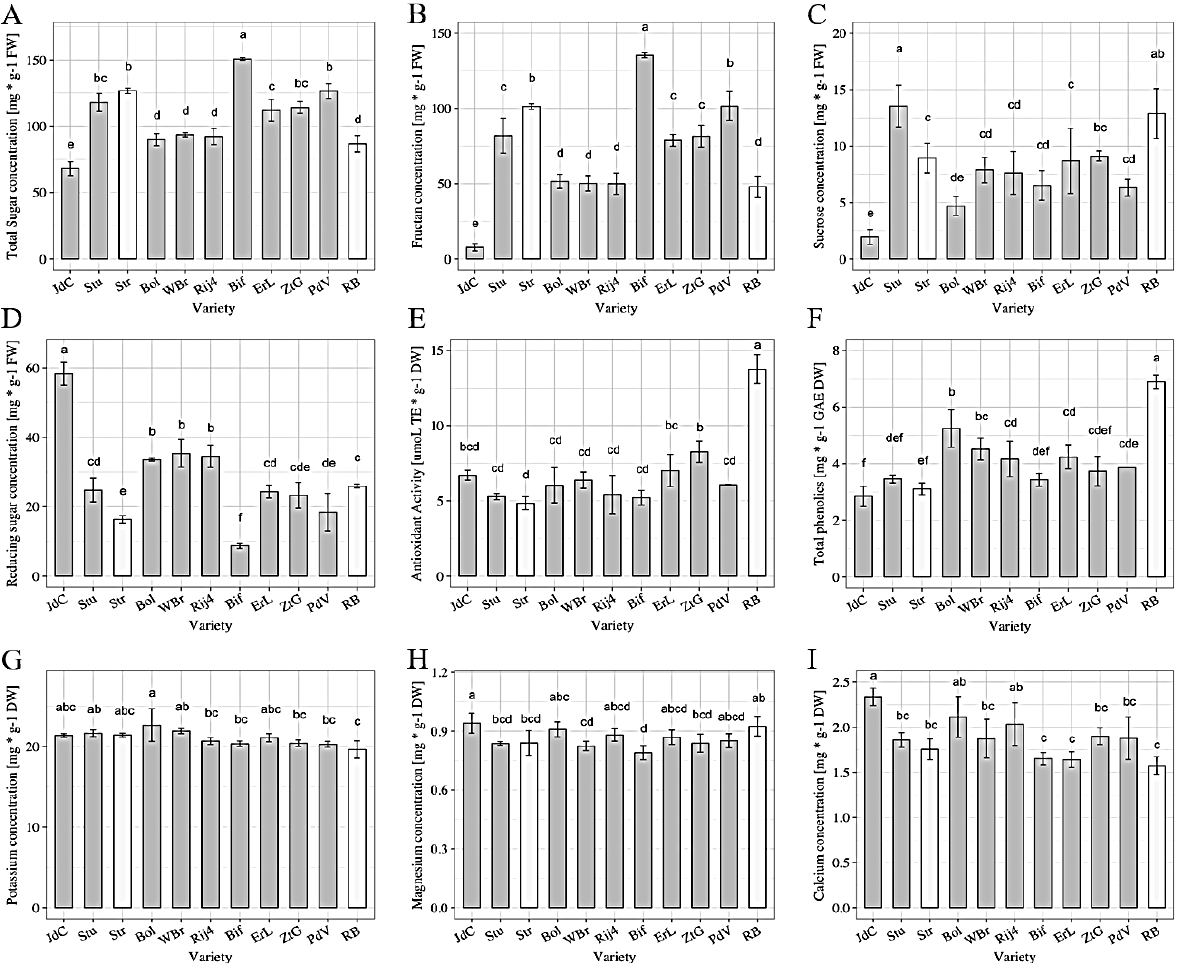
Fig. 3: Quality traits. A: Total sugar concentration, B: fructans, C: sucrose, D: reducing sugar as well as E: antioxidant activity, F: total phenolics, G: potassium, H: magnesium and, I: and calcium of the studied onion variaties. Data are mean ± SE, n = 4. Significant test by Tukey’s HSD (p < 0.05) are indicated by different letters. Control varieties Sturon and Red Baron are highlighted as blank barplots. Jaune des Cévennes (JdC), Stunova (Stu), Sturon (Str), Bolstar (Bol), Wiener Bronzekugel (WBr), Rijnsburger 4 (Rij4), Birnförmige (Bif), Erfurter Lager (ErL), Zitauer Gelbe (ZtG), Paille des Vertus (PdV), Red Baron (RB). DW = dry weight; FW = fresh weight; GAE = gallic acid equivalent; TE = Trolox Equivalent.